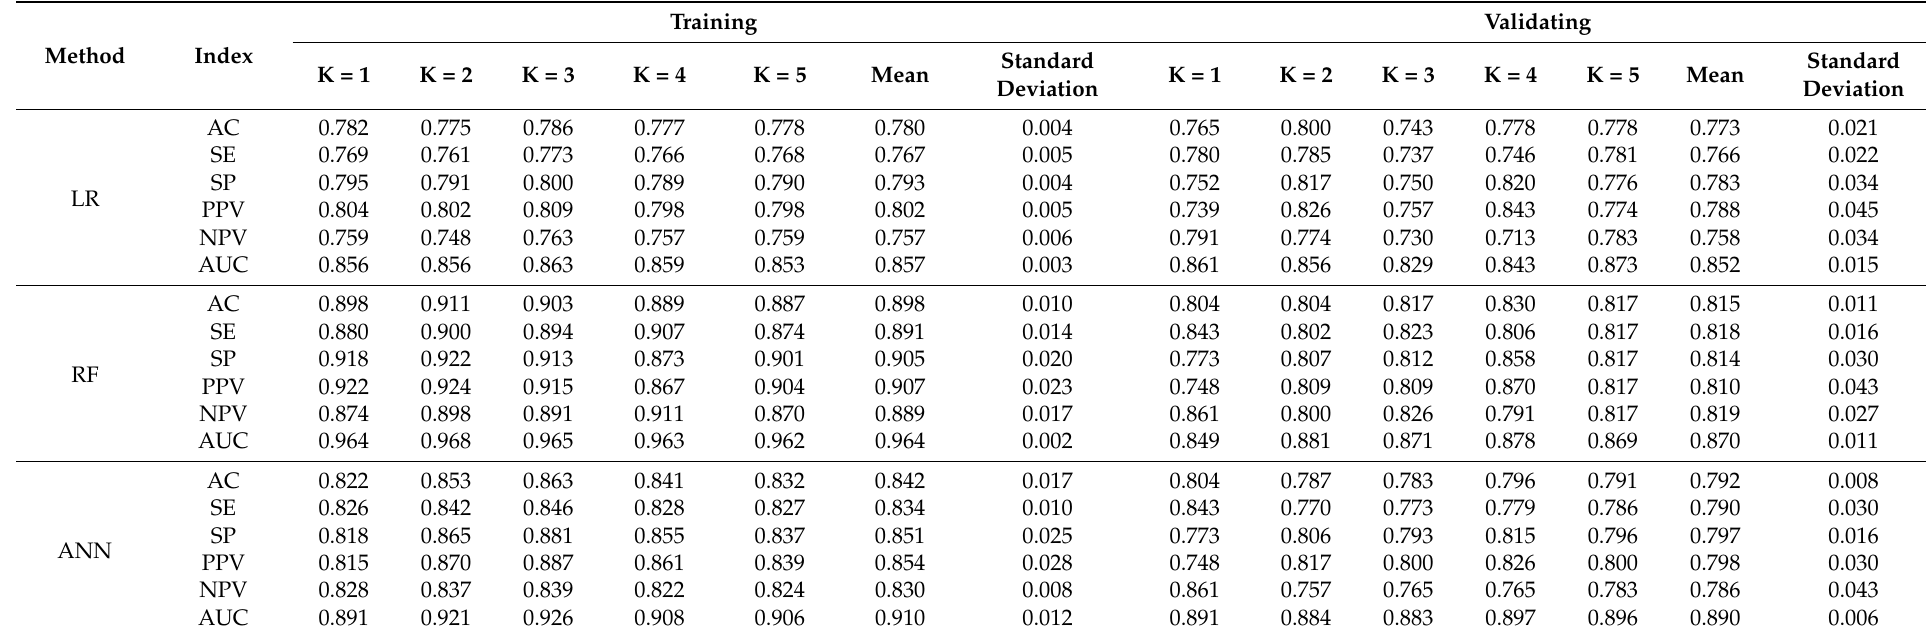
Table 4. The performances for the two slope units’ fitted landslide susceptibility models